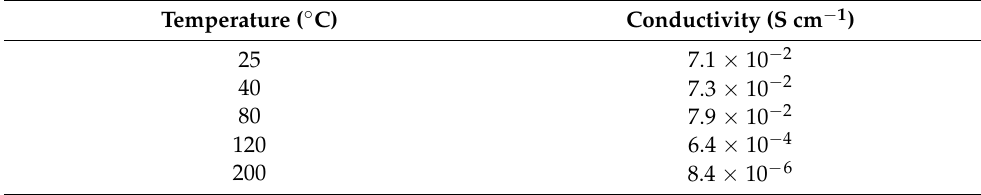
Figure 5. ( a ) Proton conductivity of phosphorylated NdC and ( b ) IEC of phosphorylated NdC. Table 2. Proton conductivity of NdC20 at various temperatures (25–200 °C).